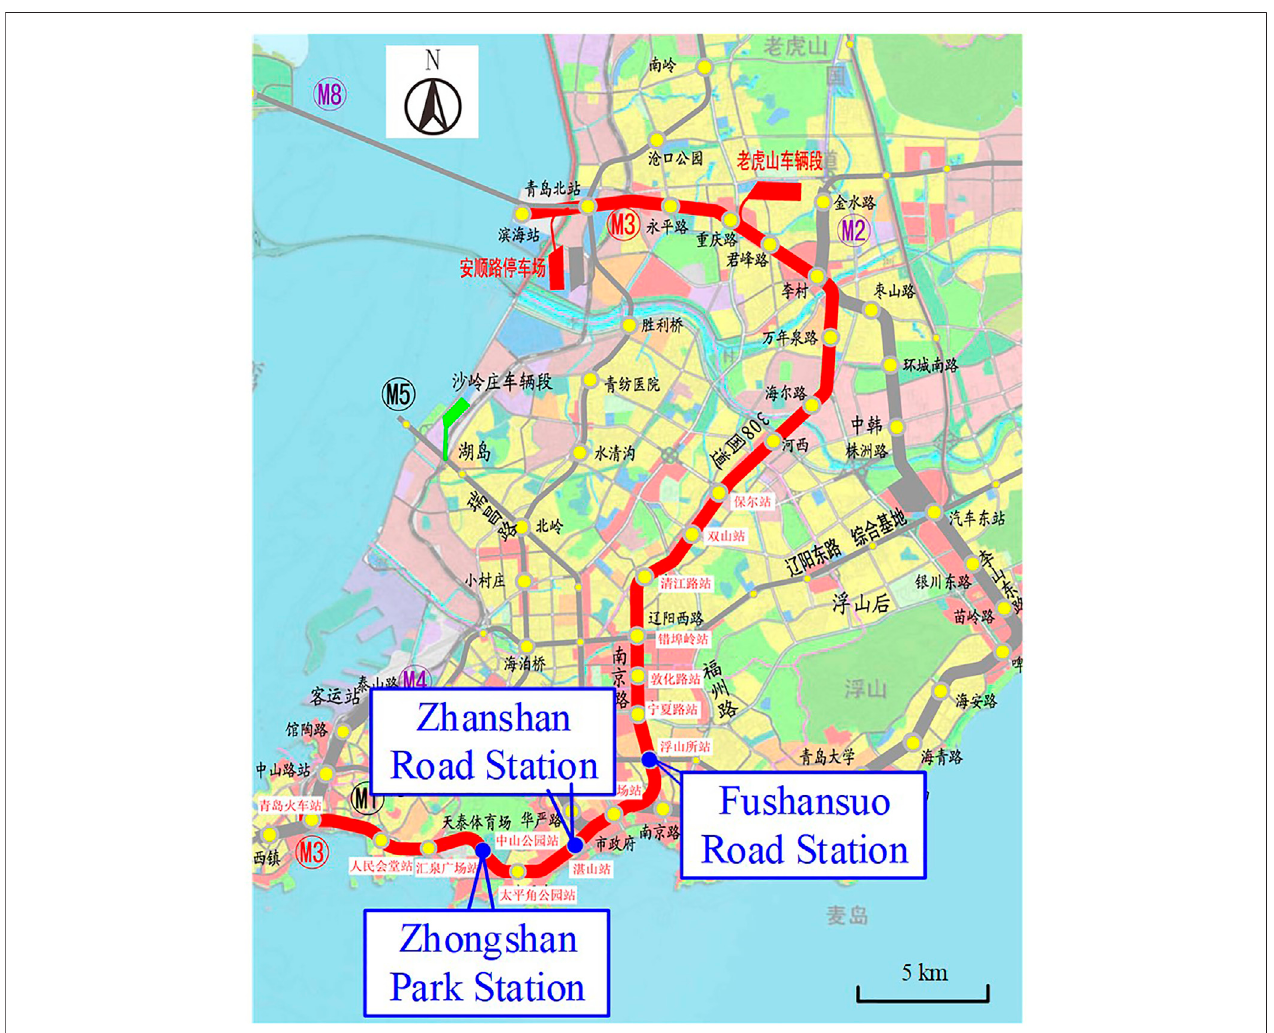
FIGURE 1 | Route diagram of Metro Line